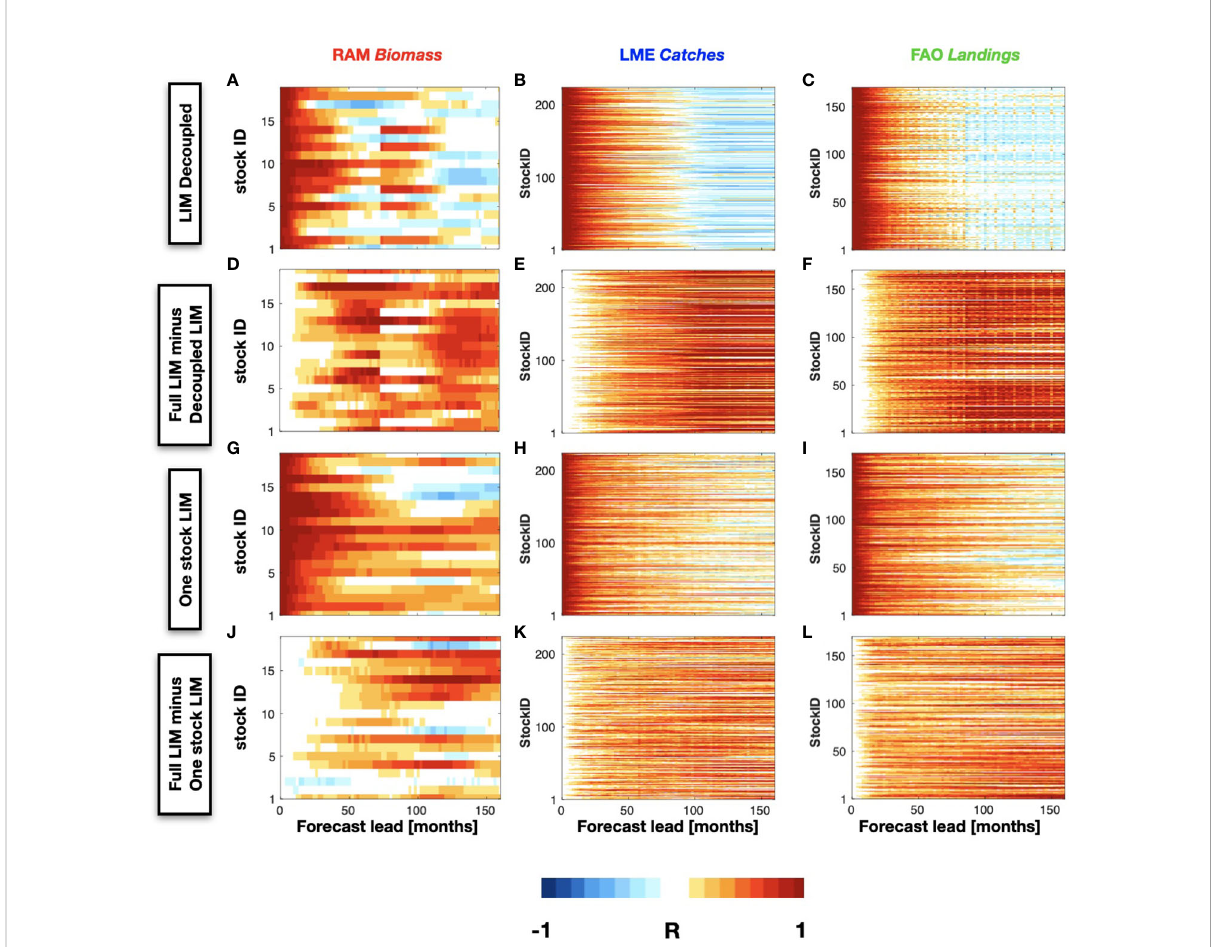
FIGURE 7 Same as Figure 5, except showing the forecast skill of the LIM where the physics and fi sh sticks are decoupled, (A) RAM, (B) LME, (C) FAO. The differences in skill between the decoupled and the full LIM case are shown in (D) , (E) , and (F) . The forecasting correlation skill as a function of different lead-times is displayed also for a LIM where each stock is forecasted independently are shown for the RAM (G) , LME (H) , and FAO (I) datasets, along with the differences from full LIM case in panels (J) , (K) , and (L) ,